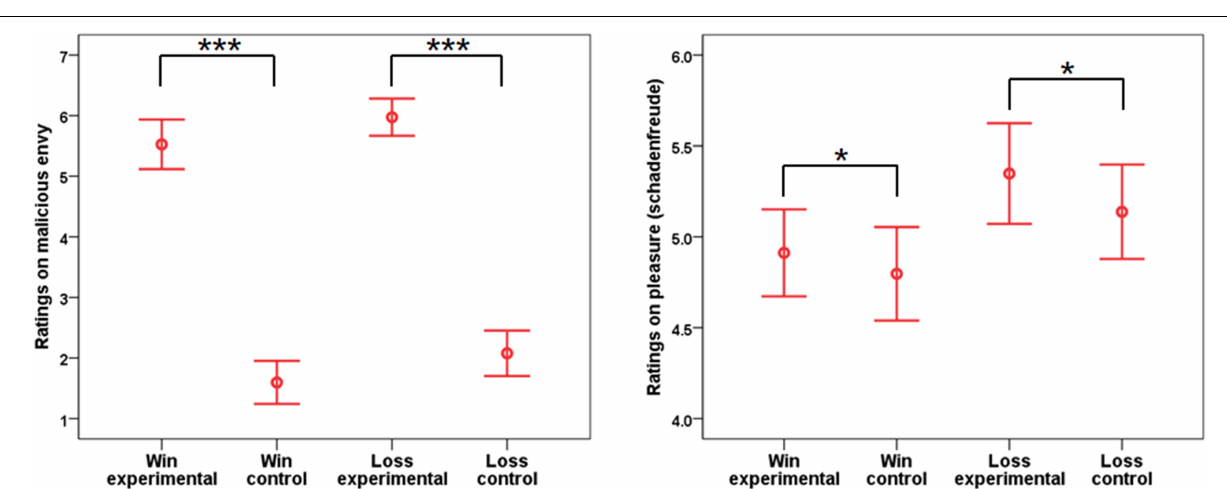
FIGURE 6 | Mean ratings on malicious envy (on the left panel) and pleasure (schadenfreude, on the right panel) in each experimental condition. Error bars show 95% confidence intervals and are adjusted for within-subject designs. The significance level of the emotional effect is marked by the number of “*” symbols. “*” and “***” indicate p < 0.05 and 0.001, respectively. Note that the significant values refer to the main effect of emotion from the